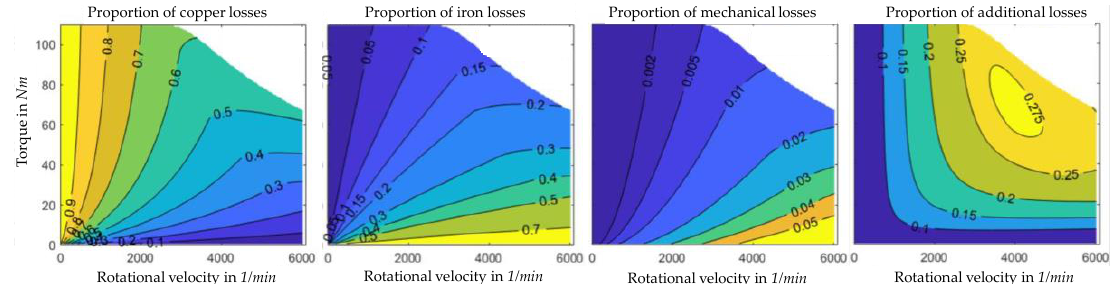
Figure 2. Proportion of different loss types in the efficiency diagram of the machine.